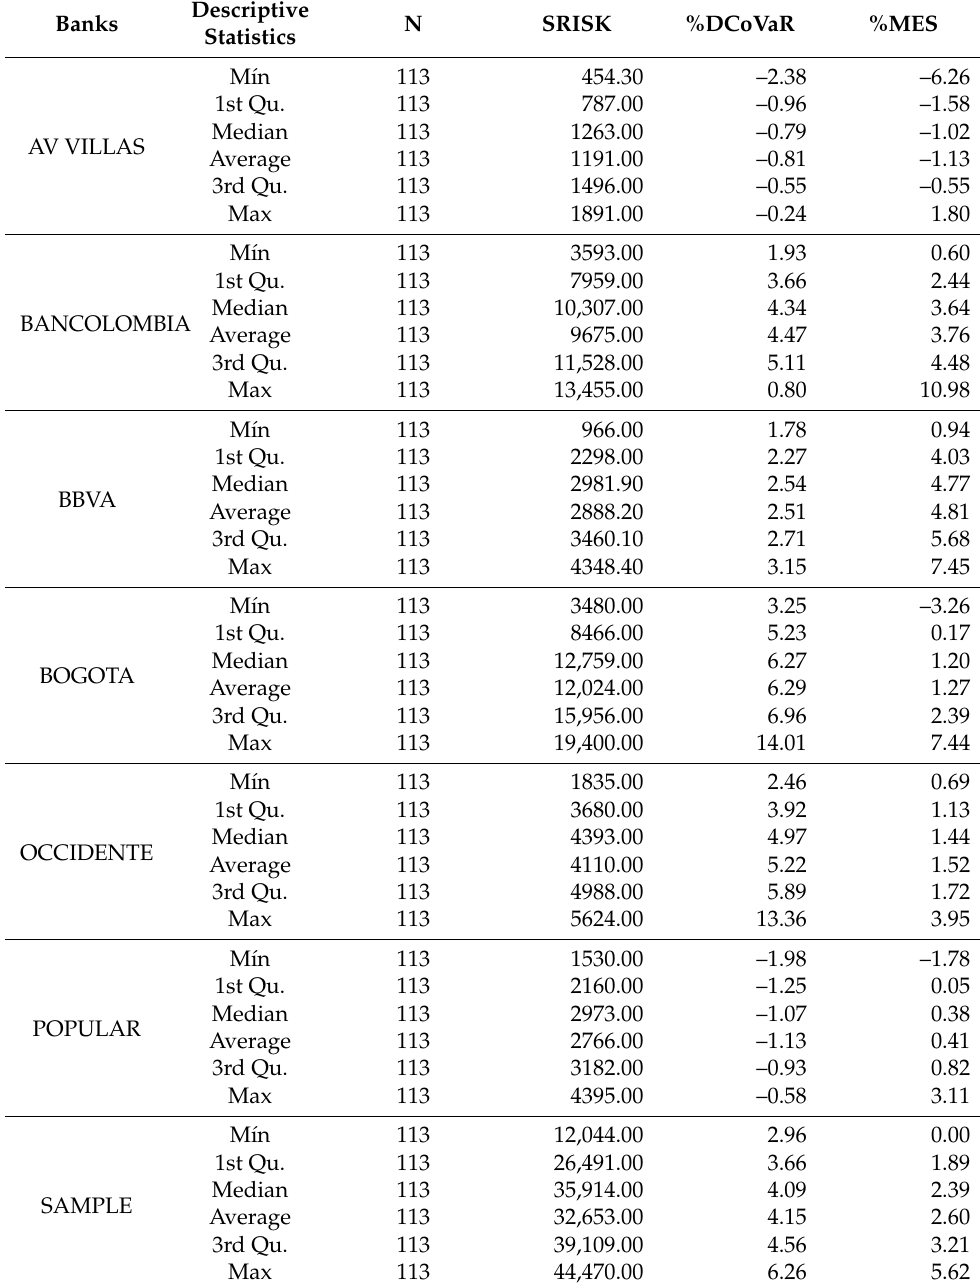
Table 4. Descriptive statistics of systemic risk